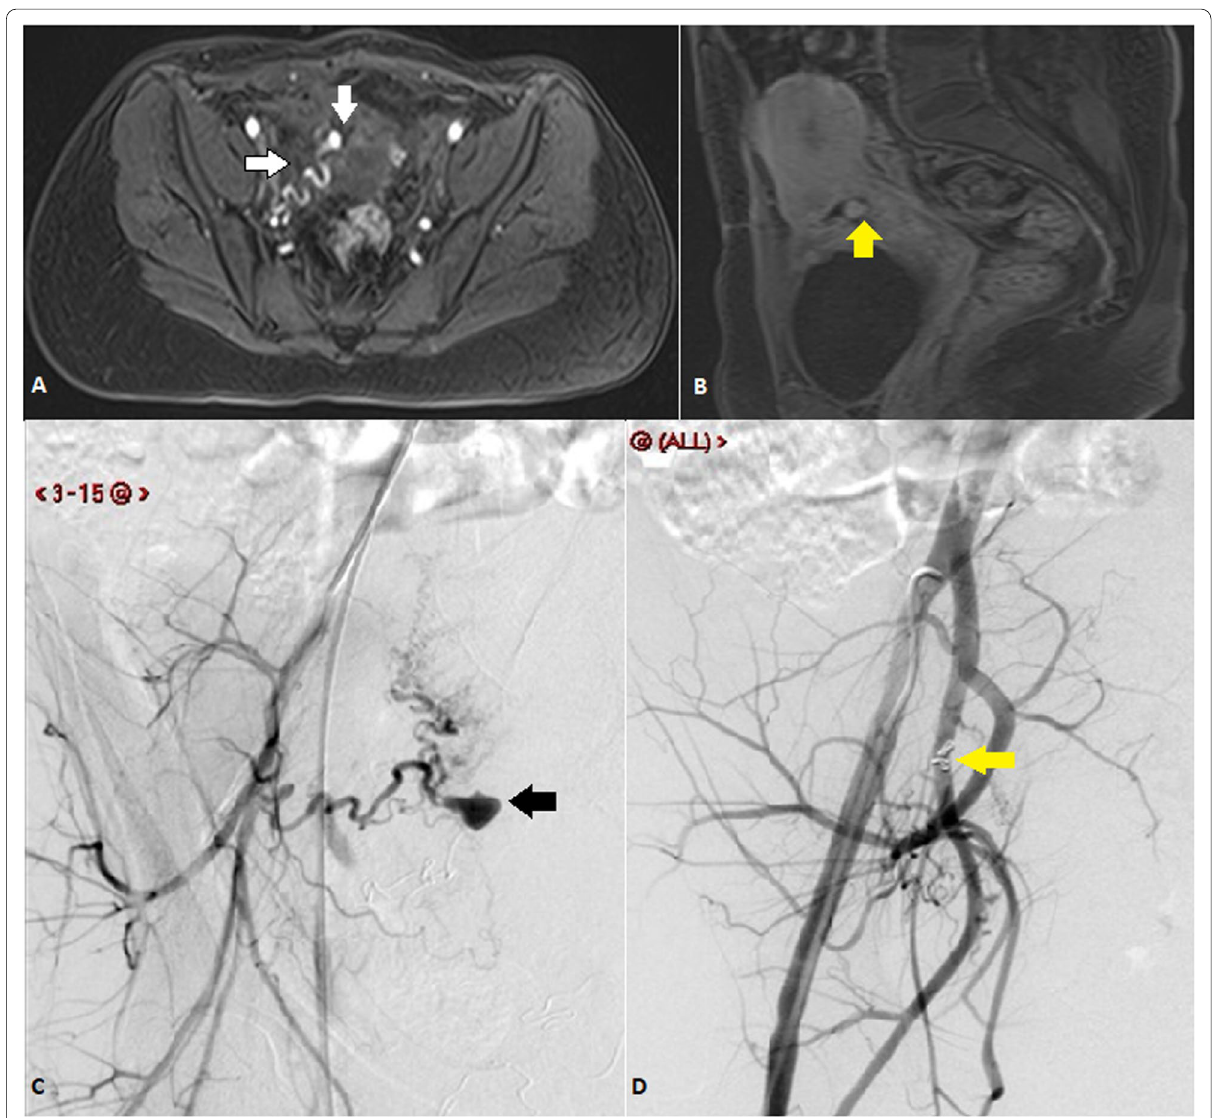
Fig. 1 Pseudoaneurysm in a 28-year-old female. The patient had intermittent vaginal bleeding after D&C for spontaneous abortion one month earlier. A , B Post-contrast MRI T1 fat sat images, show tortuous uterine arteries (white arrows) with a focal enhancing nodule in the right uterine artery at its division with arcuate arteries (yellow arrow). ( C ) Selective arteriogram of the right uterine artery showed a large pseudoaneurysm (black arrow) embolised with PVA particles. Due to persistent tiny residual collaterals along pseudoaneurysm, the left uterine artery was also embolised using coils (yellow arrow), PVA particles and gel foam